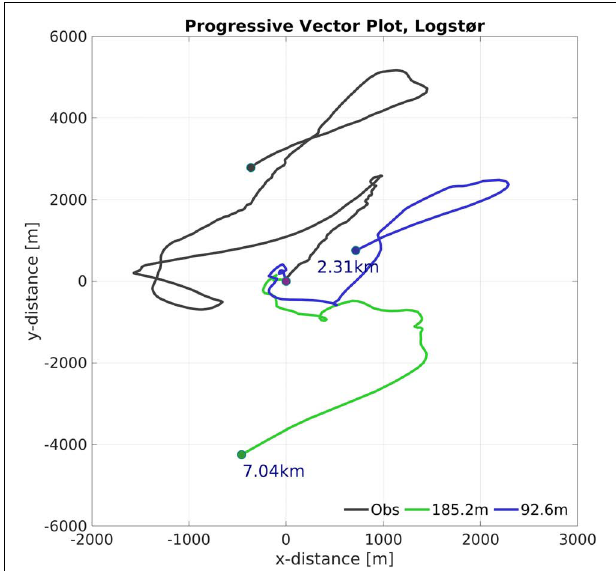
FIGURE 15 | Progressive vector plot of surface currents at Løgstør: observed currents (black) and modeled currents with a grid resolution of 185.2 m (green) and 92.6 m